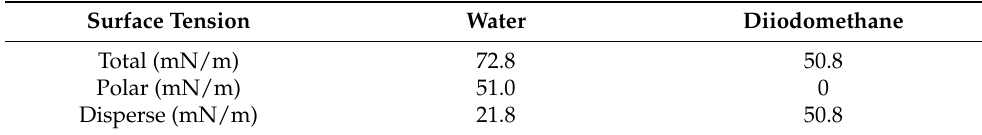
Table 2. Surface tension energy of the test liquids [7]. Surface